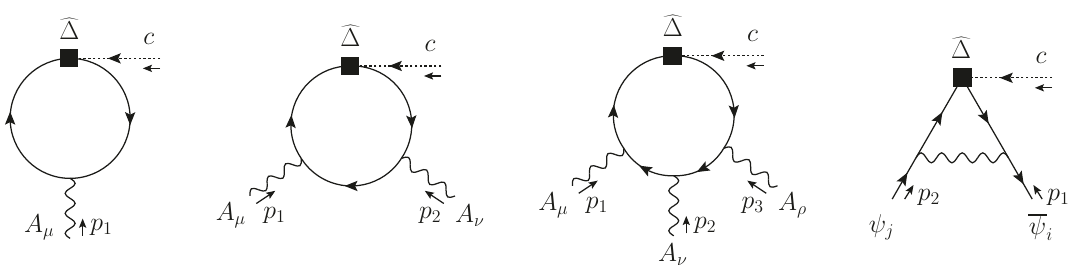
Figure 1 . The four one-loop diagrams contributing to b ∆ · Γ 1 in a relevant way. Only the first diagram provides UV divergent contributions, which are evanescent. All diagrams provide UV finite non-evanescent contributions, i.e. contributions which remain in the LIM d → 4